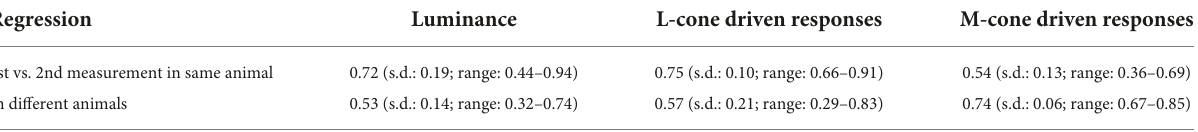
TABLE 2 Squares of correlation coefficients for comparisons of responses obtained with different stimulus conditions (5 comparisons each for 1st vs. 2nd measurements; 10 comparisons each for comparisons between different animals; all linear regressions were statistically significant). Regression Luminance vs. L-cone Luminance vs. M-cone L-cone vs. M-cone driven driven responses driven responses